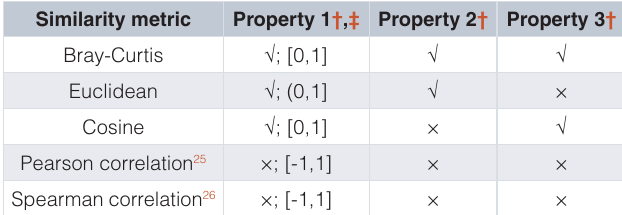
Table 1. Comparison between metrics in measurement of similarity between GTEx tissue-wide expression profiles of